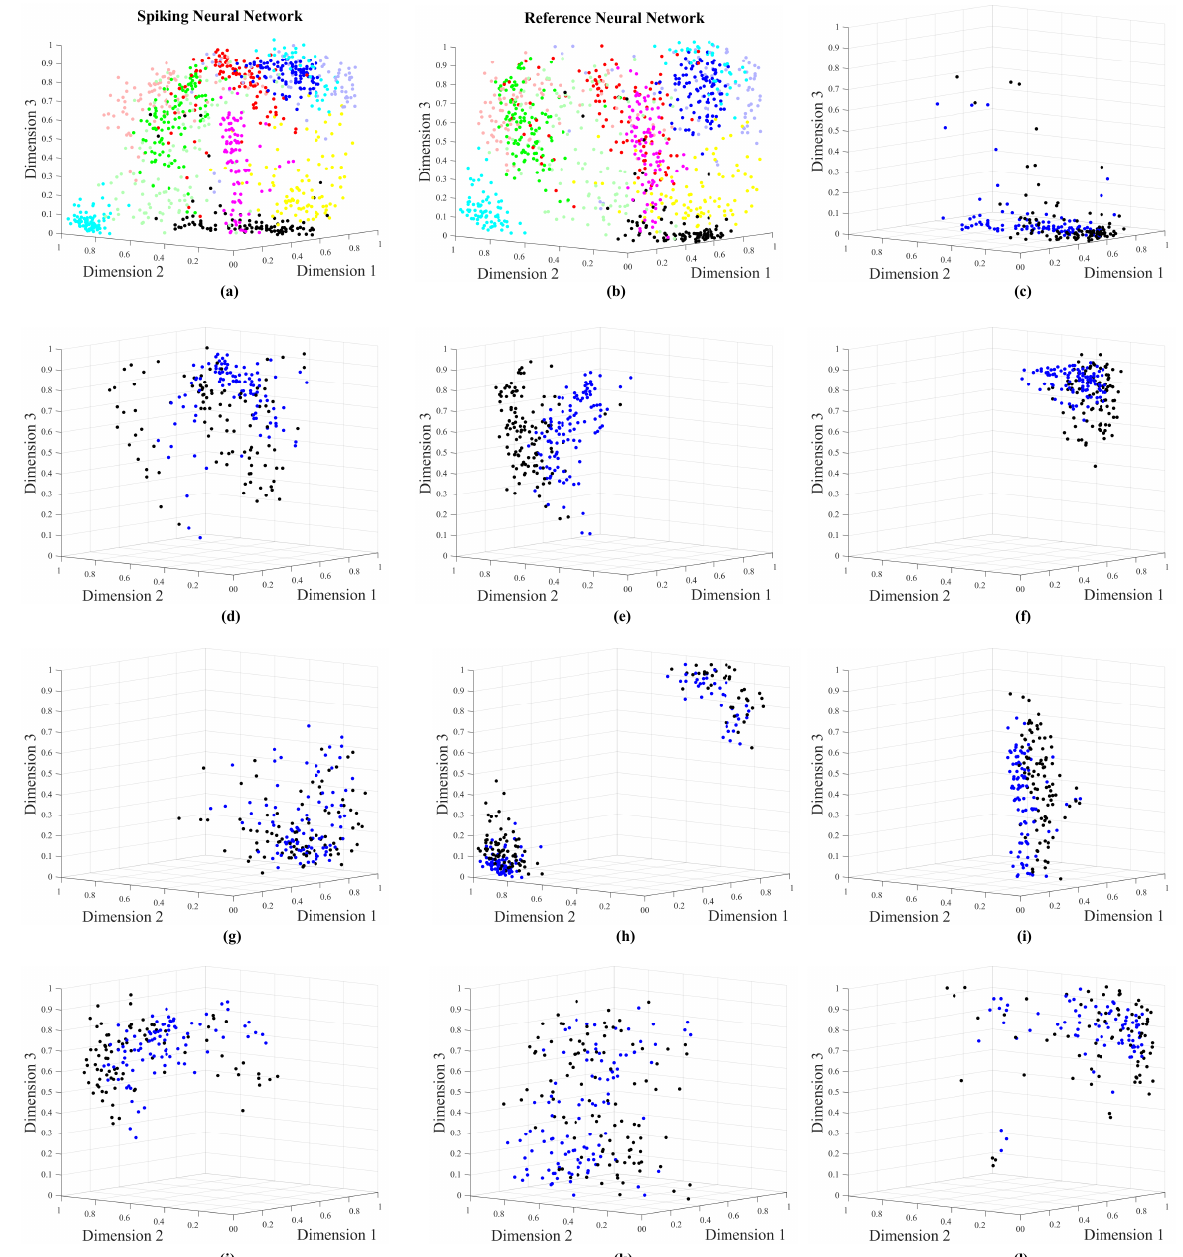
Figure 5. Class distribution for the Handwriting Numbers Database. In Figure 5a,b, each color represents a class. In Figure 5c–l the blue color corresponds to the SNN distribution and the black color to the reference continuous-sigmoid neural network distribution. ( a ) Distribution from SNN architecture. ( b ) Distribution from Autoencoder. ( c ) Number “zero”. ( d ) Number “one”. ( e ) Number “two”. ( f ) Number “three”. ( g ) Number “four”. ( h ) Number “five”. ( i ) Number “six”. ( j ) Number “seven”. ( k ) Number “eight”. ( l ) Number